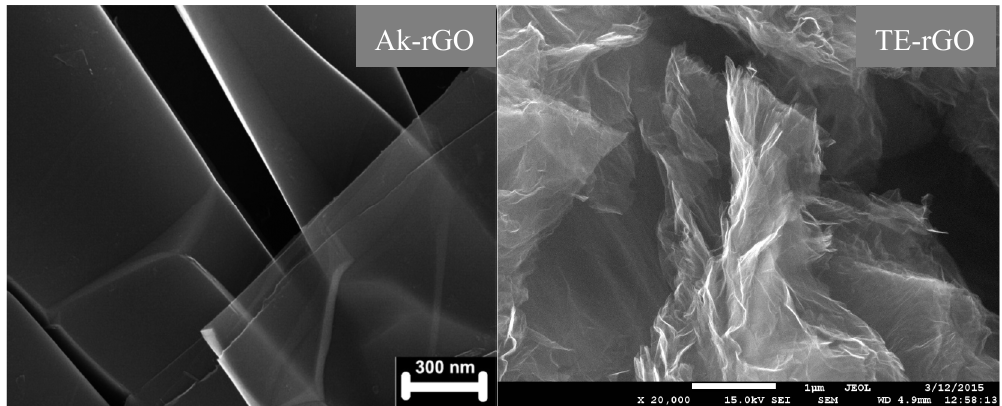
Figure 2. SEM images of technical graphenes Ak-rGO [27] and TE-rGO [28]. Adapted from Ref. [18]. Table 1. Structural parameters of amorphous carbons. 1